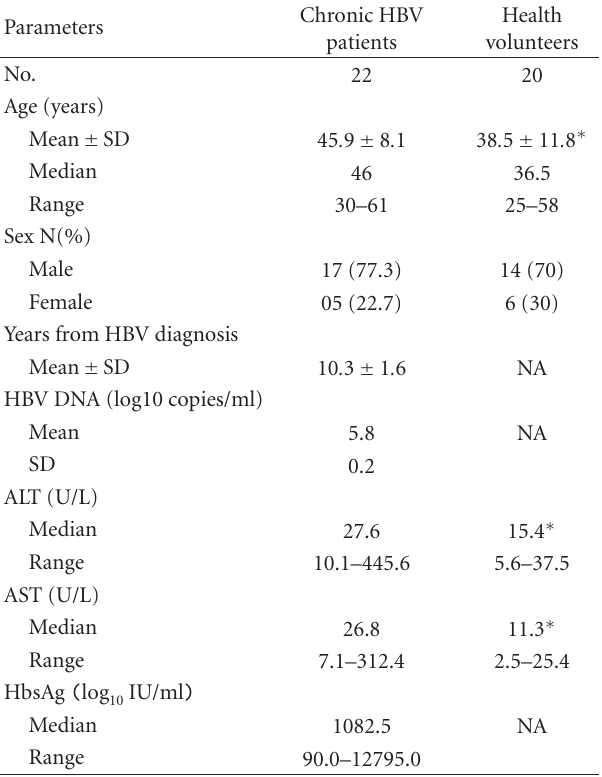
Table 1: Demographic profiles of study participants. Table 2: Comparison of intracellular Th1/Th2 cytokines in chronic HBV patients and healthy